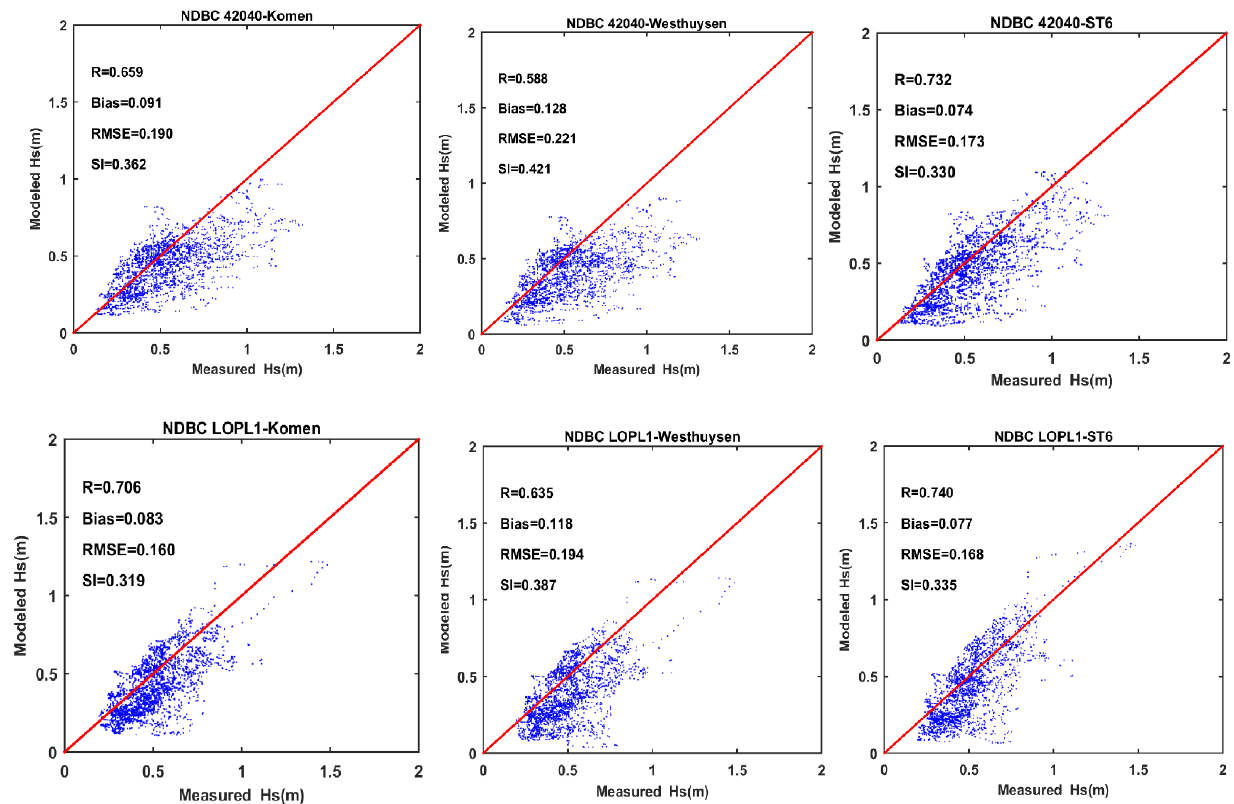
Figure 7. Scatter plots and model performance statistics for simulated wave height using the three whitecapping formulations compared to observations. Upper panels: NDBC 4040, lower panels: LOPL1, left panels: Komen, middle panels: Westhuysen, right panels: ST6.